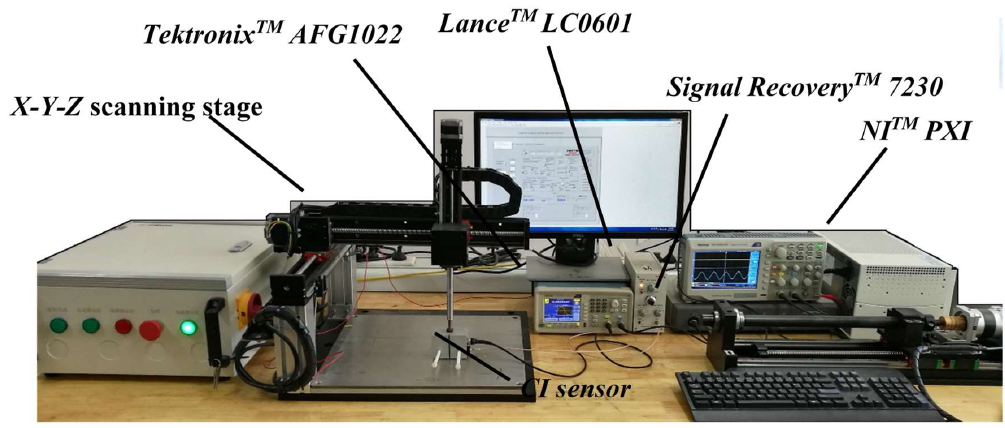
Figure 15. Experimental Setup.